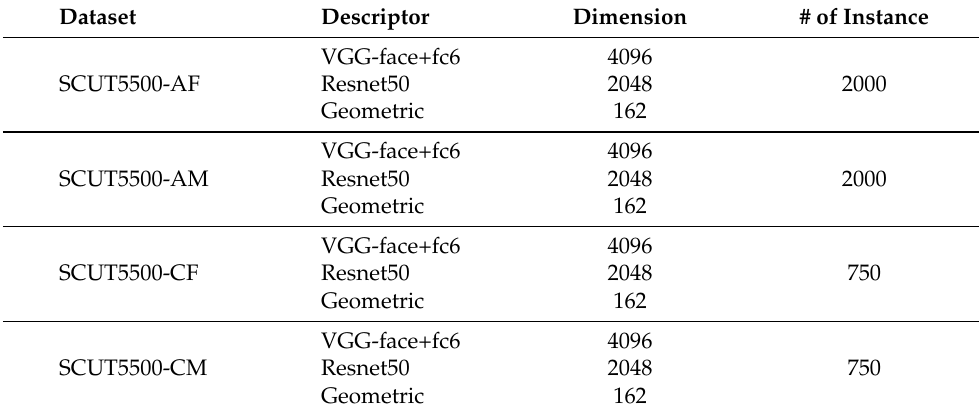
Table 2. Face beauty dataset and image